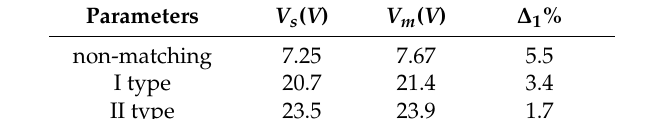
Figure 12. The transient test of the pitch-catch setup with EIM network, ( a ) the test platform diagram; ( b ) the test platform picture. Table 6. The received voltages of measured and simulated for the pitch-catch setup.